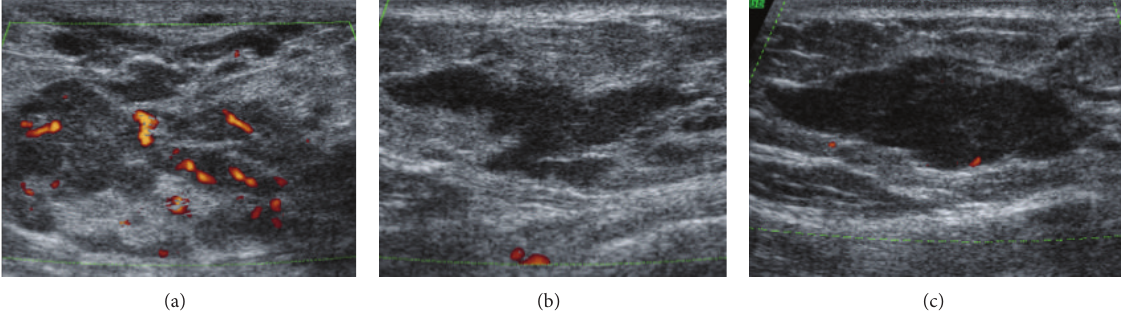
Figure 2: Breast ultrasonography : ultrasonography of the left breast confirmed a hypoechoic, irregular, indistinct mass, with internal vascularity, measuring 47 × 16 mm (a). Ultrasonography of the right breast depicted two irregular, hypoechoic, circumscribed, parallel to the skin masses measuring 29 × 9 mm and 17 × 8 mm in the lower outer quadrant, near the inframammary fold (b and c).